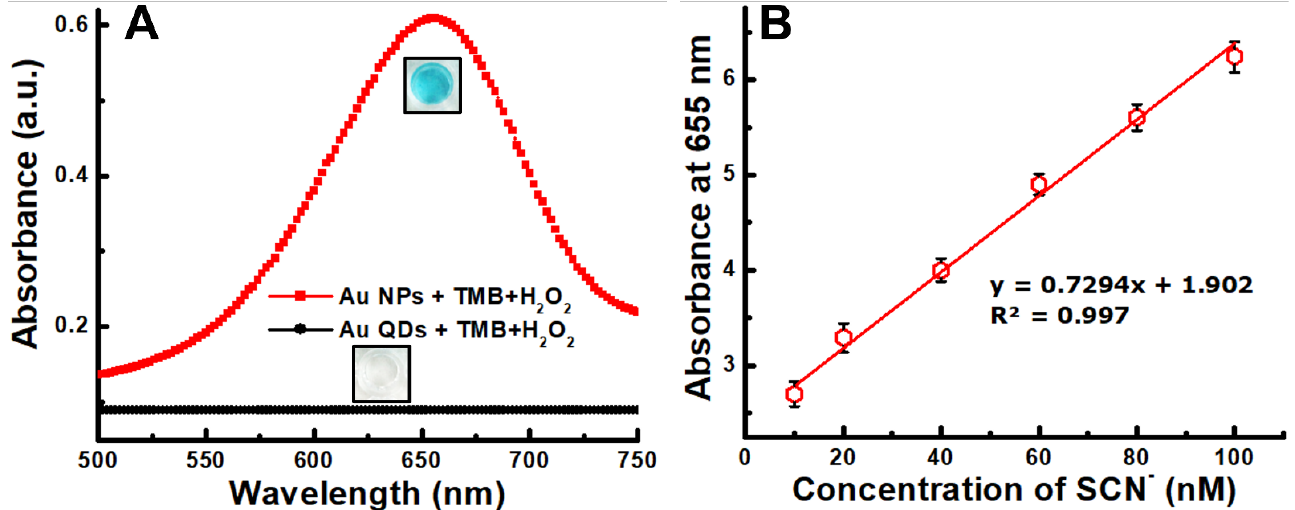
Figure 3. Nanozymatic activity of Au NPs and Au QDs ( A ) (inset: the color of the solution) and ( B ) calibration plot of differently concentrated SCN - (absorbance at 655 nm).